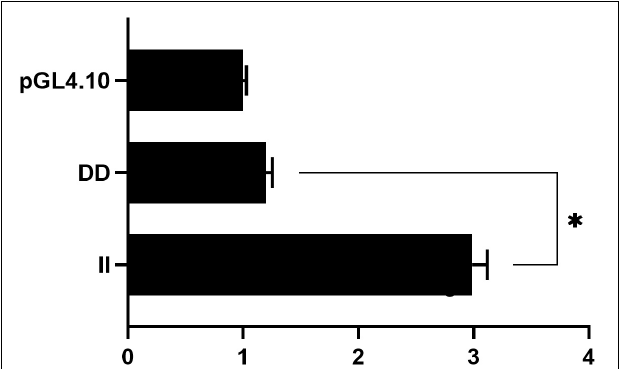
FIGURE 6 | Relative luciferase activity detection of ADPRHL1 gene promoter. Luciferase activity in HEK293T cells transfected with recombinant plasmids containing serial promoter fragments (pGL4-II, pGL4-DD) of the ADPRHL1 promoter. The backbone vector pGL4.10 was used as a negative control; Each experiment was repeated at least five times. The data were the mean ± standard error (S.E.) of the normalized luciferase activity ( ∗ P <